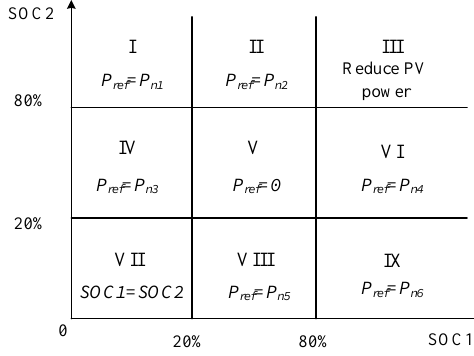
Figure 6. Quadrantal diagram of outer loop